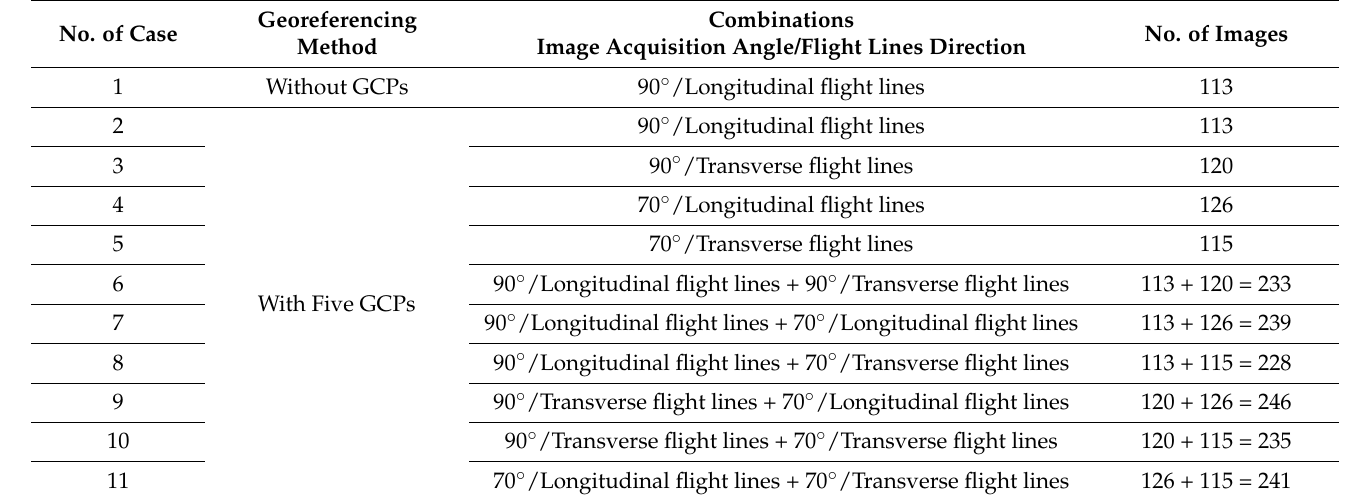
Table 1. The eleven cases of processed images in this study.